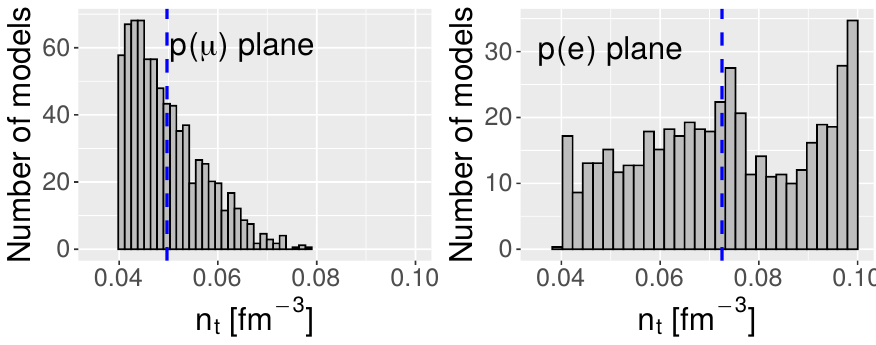
Figure 2. Crust–core transition densities, n t , for the P ( µ t ) ( left ) and P ( (cid:101) t ) ( right ) matching procedures. The blue dashed line represents the mean